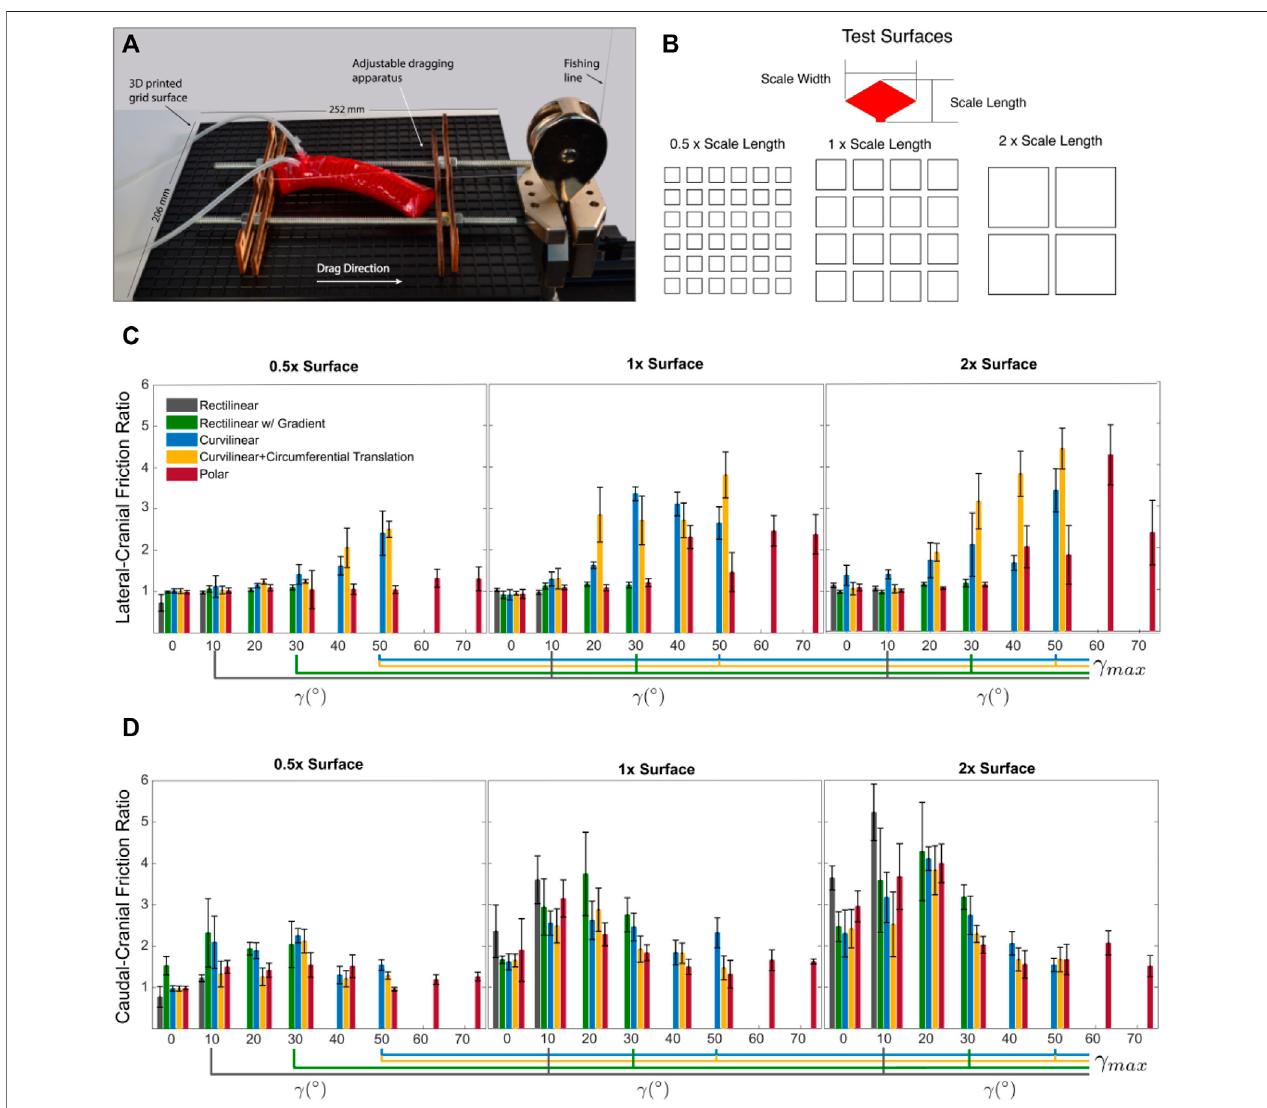
FIGURE 4 | (A) Experimental apparatus for measuring directional friction. Actuator with polar lattice skin on 2x scale length surface. (B) Test surface grid spacing normalized by scale length. (C) Lateral-cranial friction ratio. (D) caudal-cranial friction ratio.